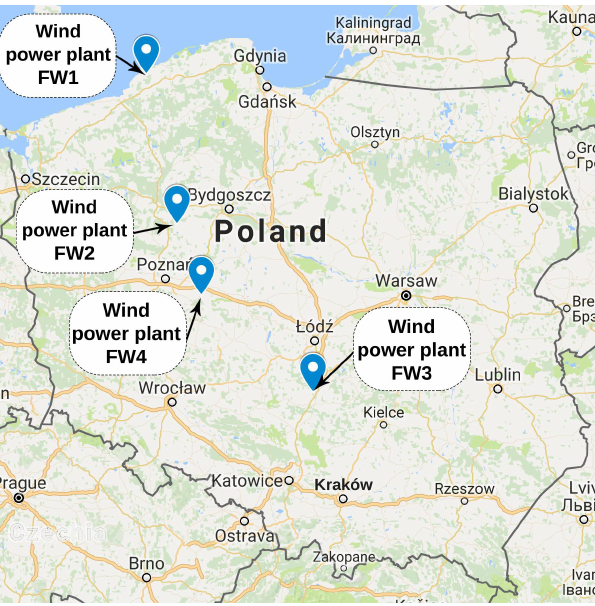
Figure 2. Location of the analyzed facilities on the map of